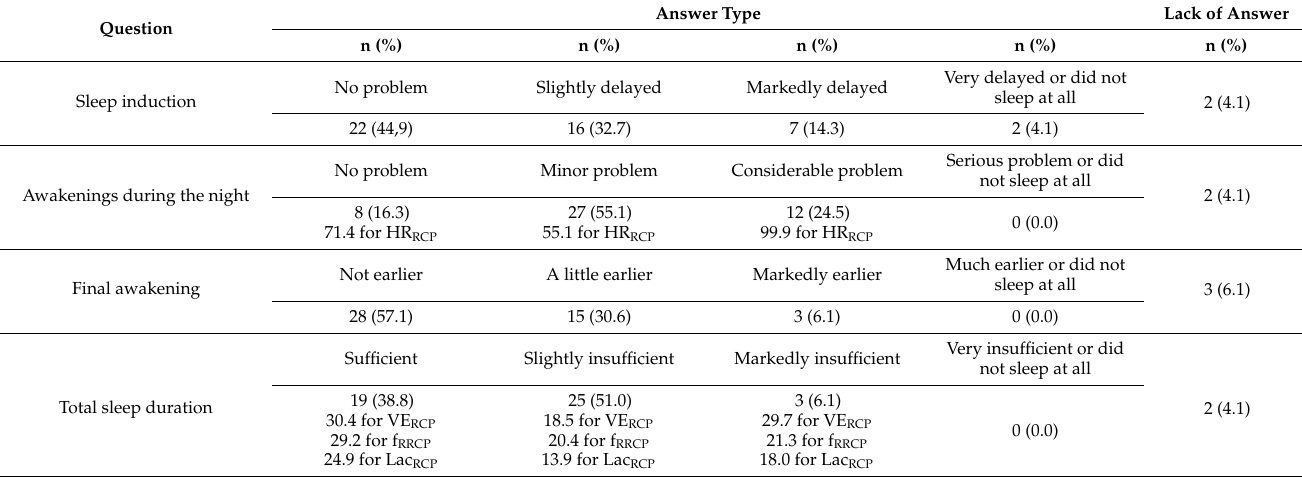
Table 2. Results of answers to questions related to